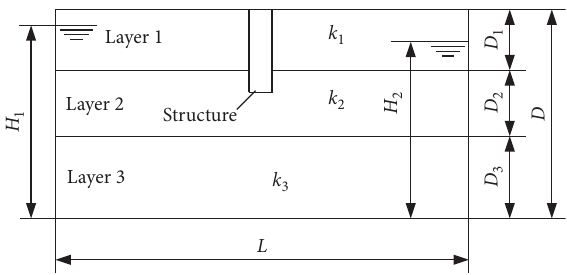
Figure 20: Tree-layer soil distribution and equivalent diagram. Table 4: Comparison of the MWLI obtained by the simulation and the simplifed calculation method6t. MWLI Dimensions b (m) × l (m) × d (m)